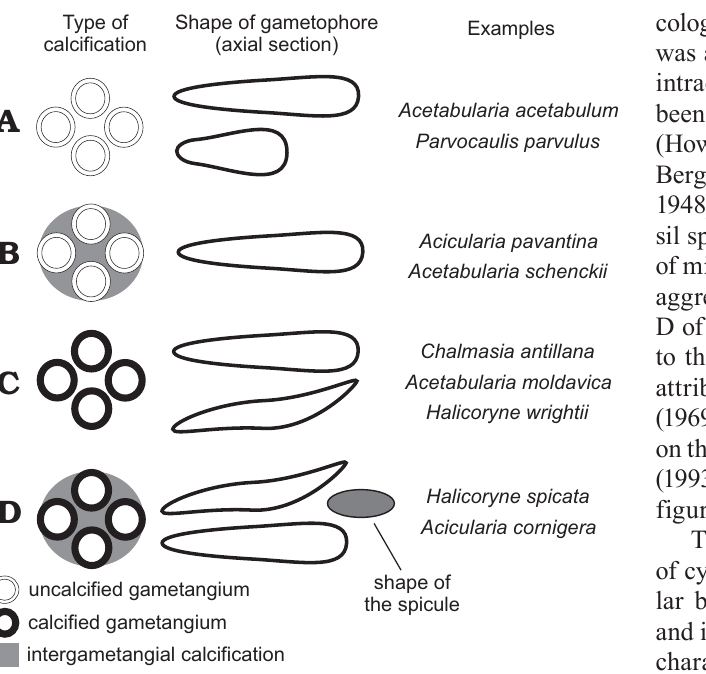
Fig. 11. Scheme of intracellular mineralization in polyphysaceans (gameto- phores are sketched in cross section). A . Gametangia and intergametangial space not mineralized. B . Gametangia unmineralized, intergametangial space mineralized. C . Gametangia mineralized, intergametangial space not mineralized. D . Gametangia and intergametangial space